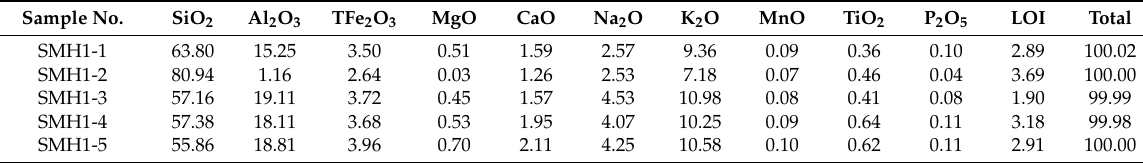
Table 2. Whole-rock major oxides (wt. %) of syenites in the Saima deposit.